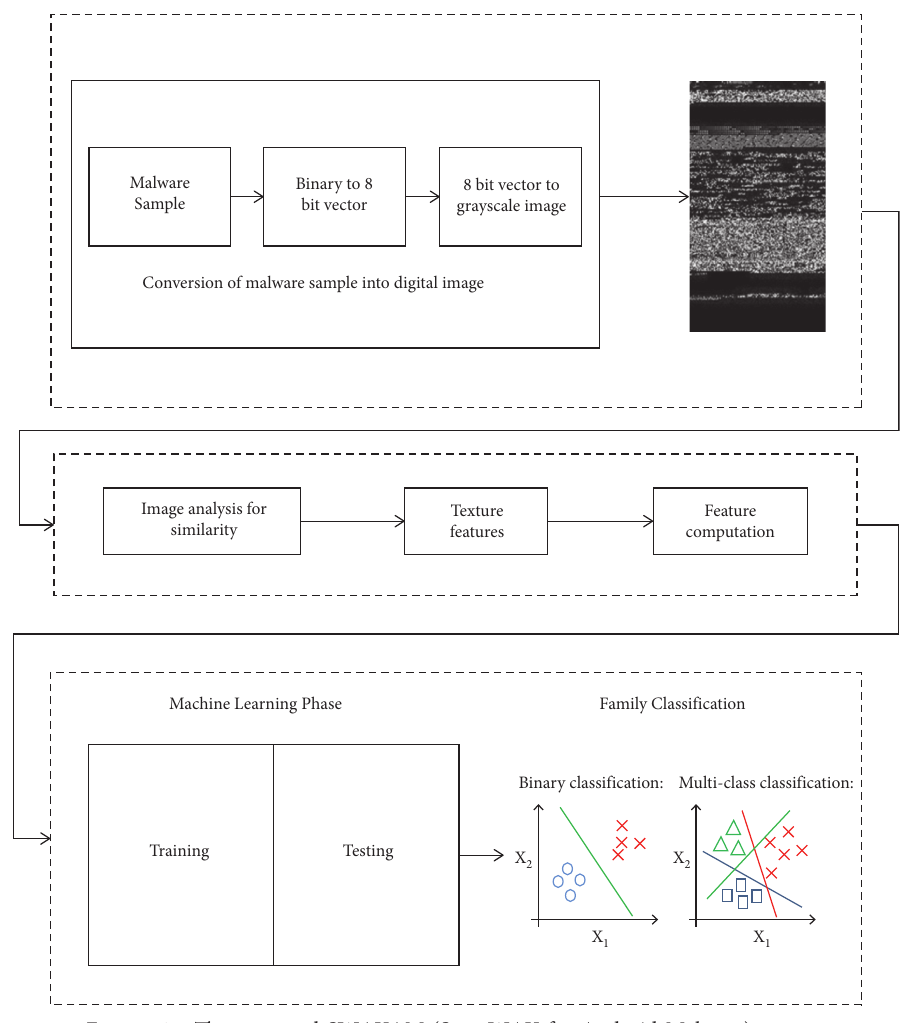
Figure 17: The proposed SWAYAM (Stop WAY for Android Malware)